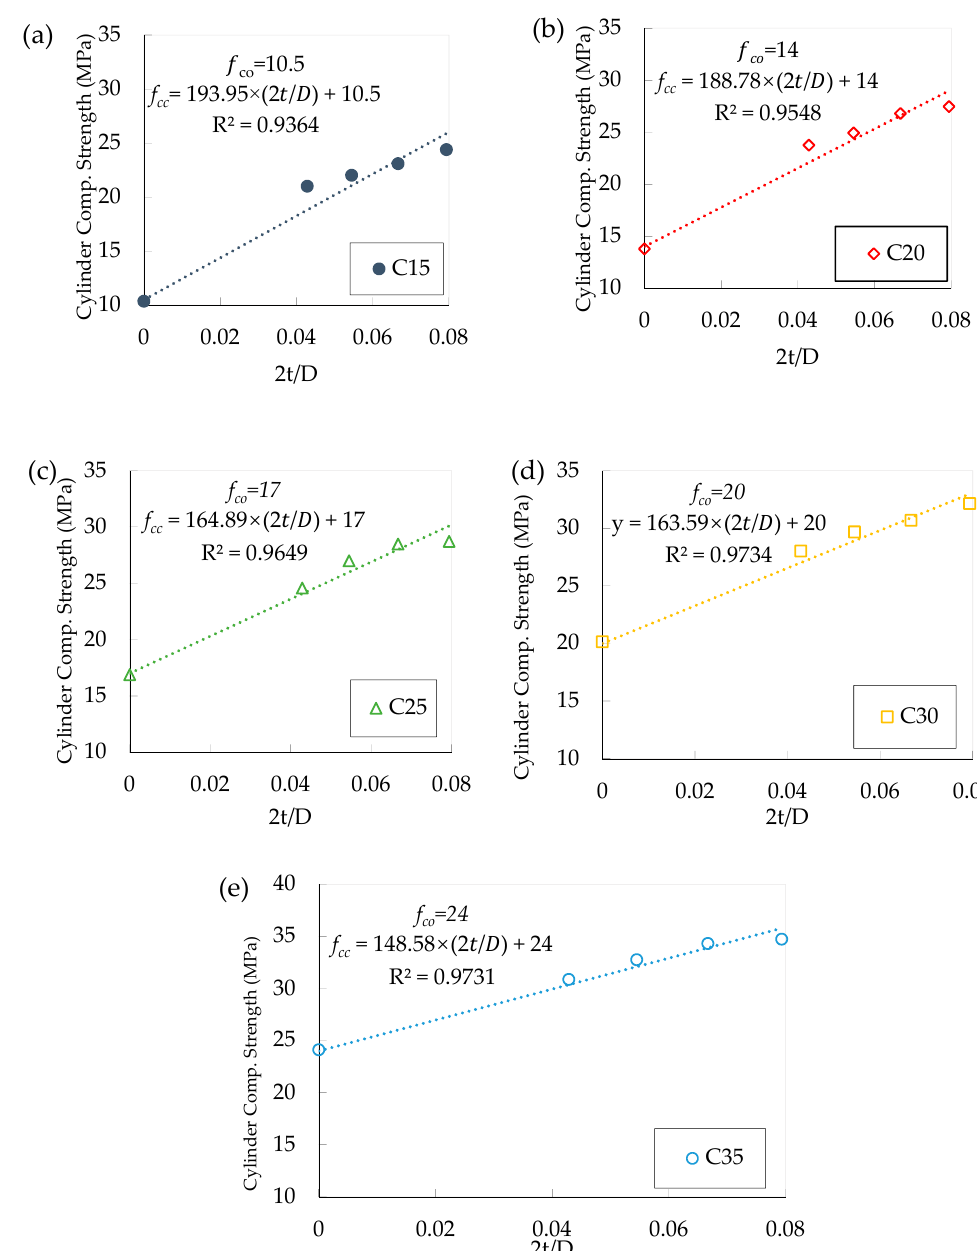
Figure 11. E ff ect of thickness to diameter ratio (2t / D) on strength of uPVC confined concrete for: ( a ) C15, Figure 11. Effect of thickness to diameter ratio (2t/D) on strength of uPVC confined concrete for: ( a ) ( b ) C20, ( c ) C25, ( d ) C30, and ( e ) C15, ( b ) C20, ( c ) C25, ( d ) C30, and ( e ) C35.